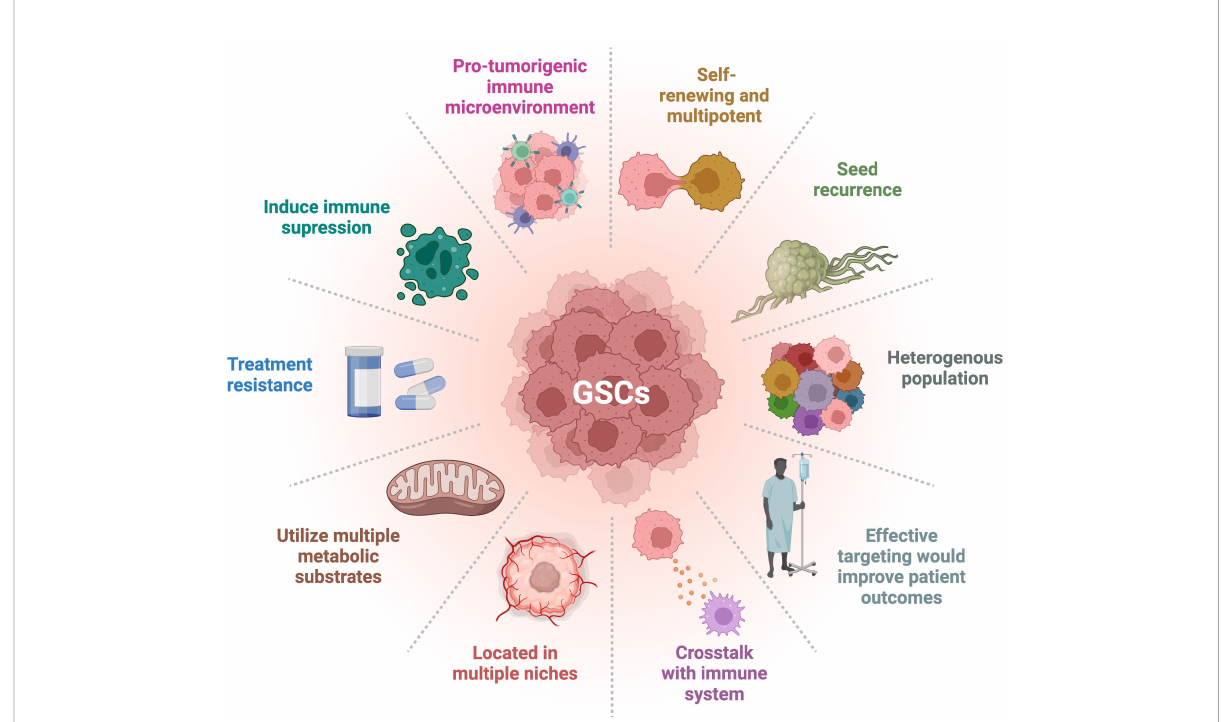
FIGURE 1 Hallmarks of GSCs. GSCs have many distinct characteristics that differentiate them from other types of tumor cells. Their degree of stemness is related to the hallmarks presented. Adapted from “ Hallmarks of Cancer: Circle ” , by BioRender.com (2022). Retrieved from https://app.biorender.